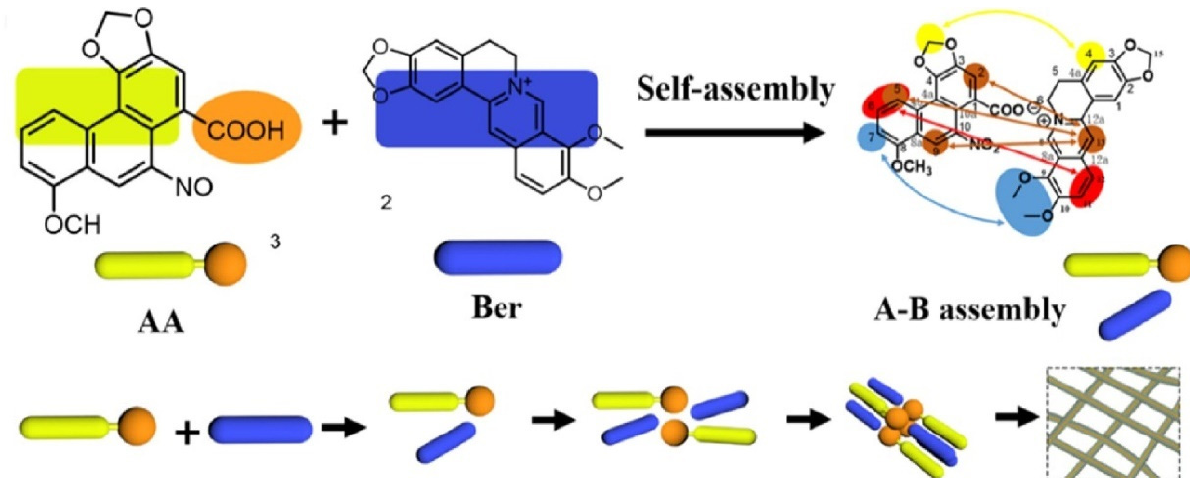
Figure 5. Schematic representation of the self-assembly mechanism of the berberine (Ber)-aristolochic acid (AA) supramolecular structure [31] .